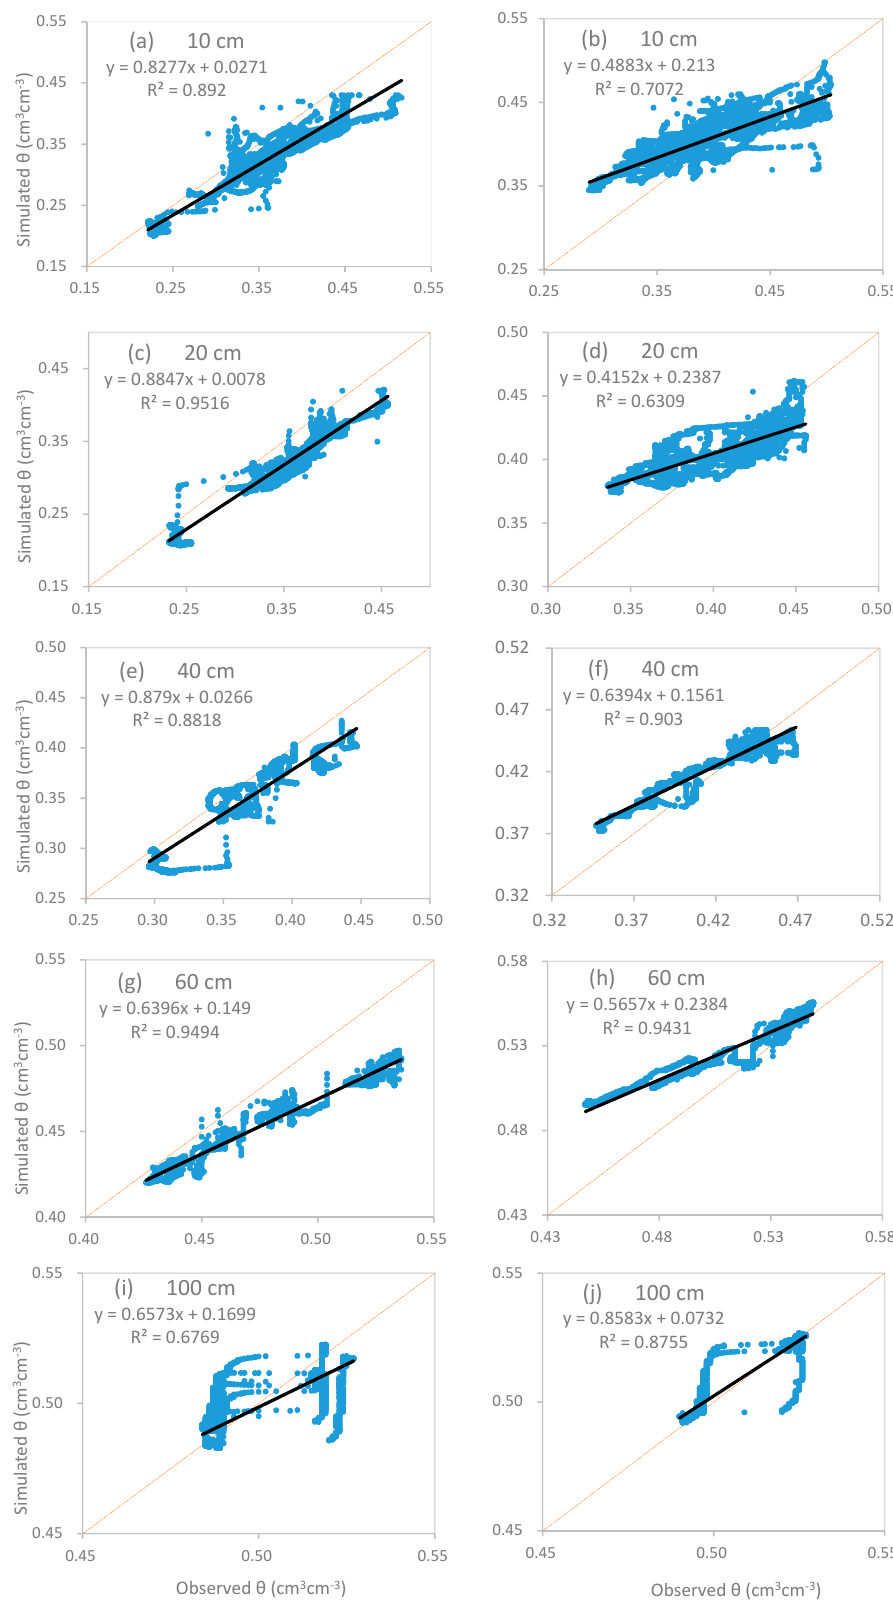
Figure 6. Simulated results (curves) versus observed (dots) soil water contents at different depths from 1 January 2014 to 30 June 2014 for calibration ( a , c , e , g , i ) and from 1 July 2014 to 31 December 2014 for validation ( b , d , f , h , j ). Daily rainfall measurements were also plotted.